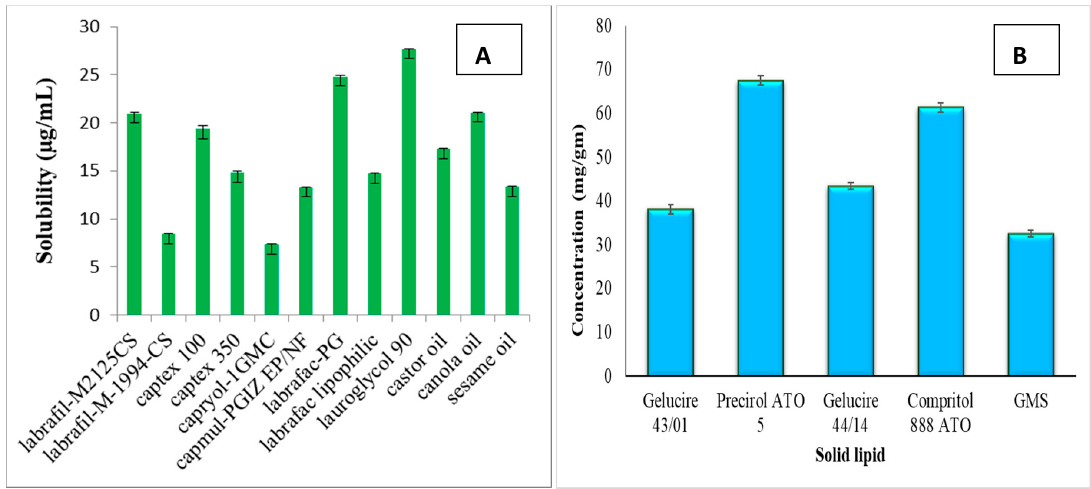
Figure 2. Solubility of atazanavir in ( A ) liquid lipids and ( B ) solid lipids.